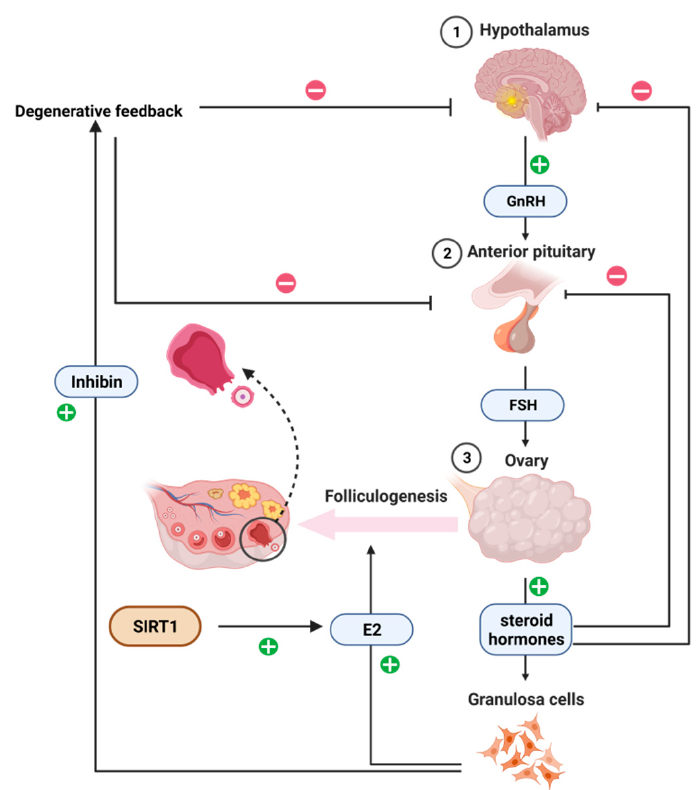
Figure 2. Regulation of steroid hormone synthesis by the hypothalamic–pituitary–ovarian axis.